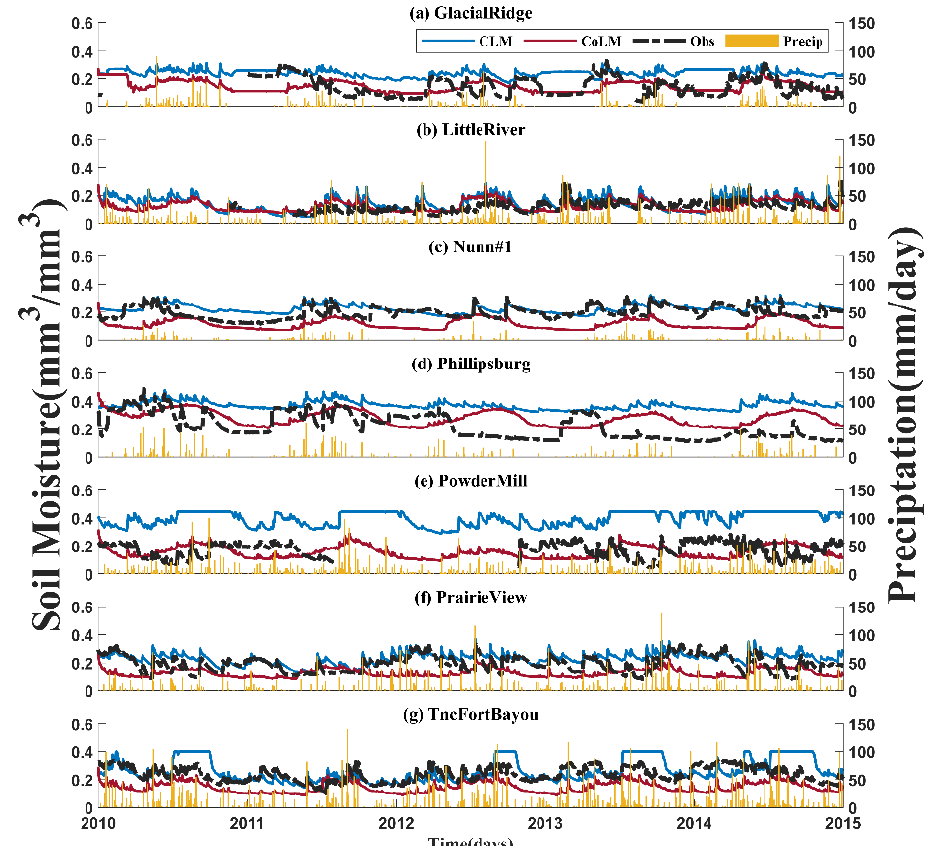
Figure 4. Simulated and observed temporal soil moisture variations at the SCAN sites for 2010–2014 at a soil depth of 0.2032 m. The blue line is the CLM5 simulation, the red line is the CoLM2014 simulation, the dashed line is the observations, and the yellow bars are the daily cumulative